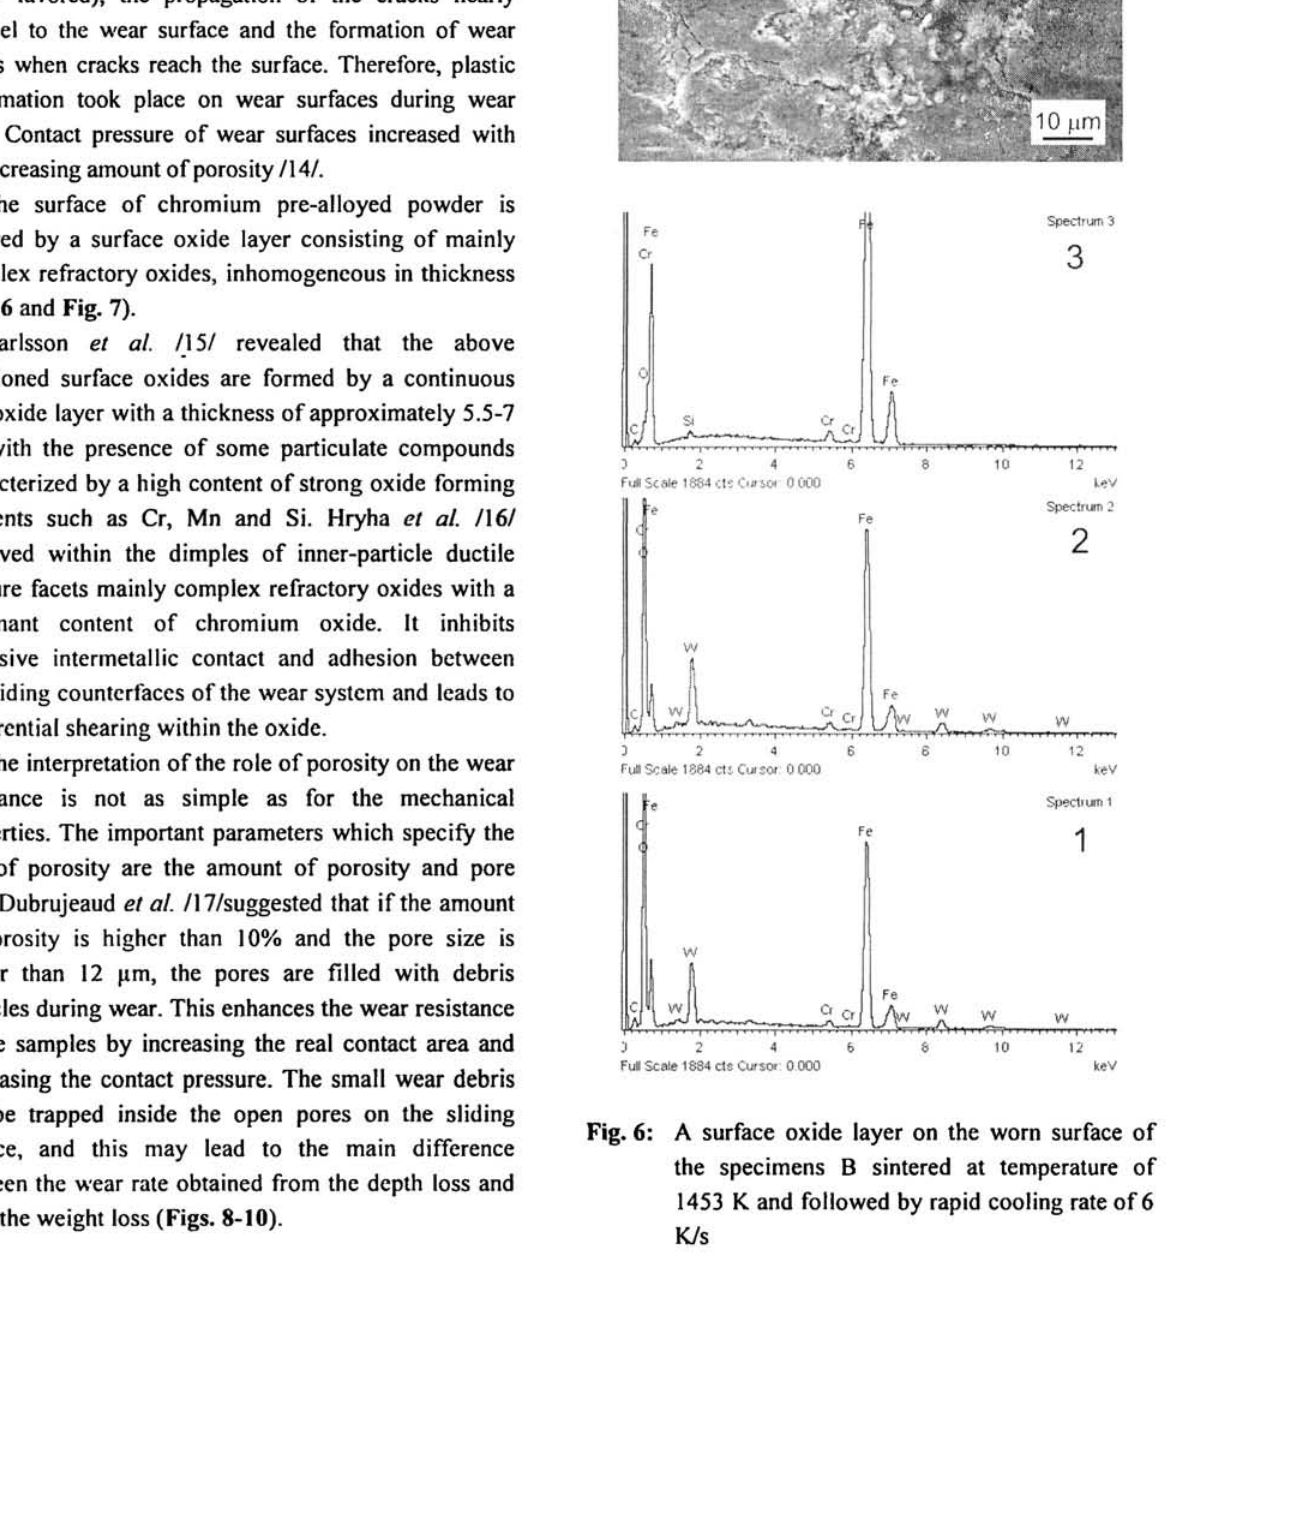
Fig. 6: A surface oxide layer on the worn surface of the specimens B sintered at temperature of 1453 K and followed by rapid cooling rate of 6